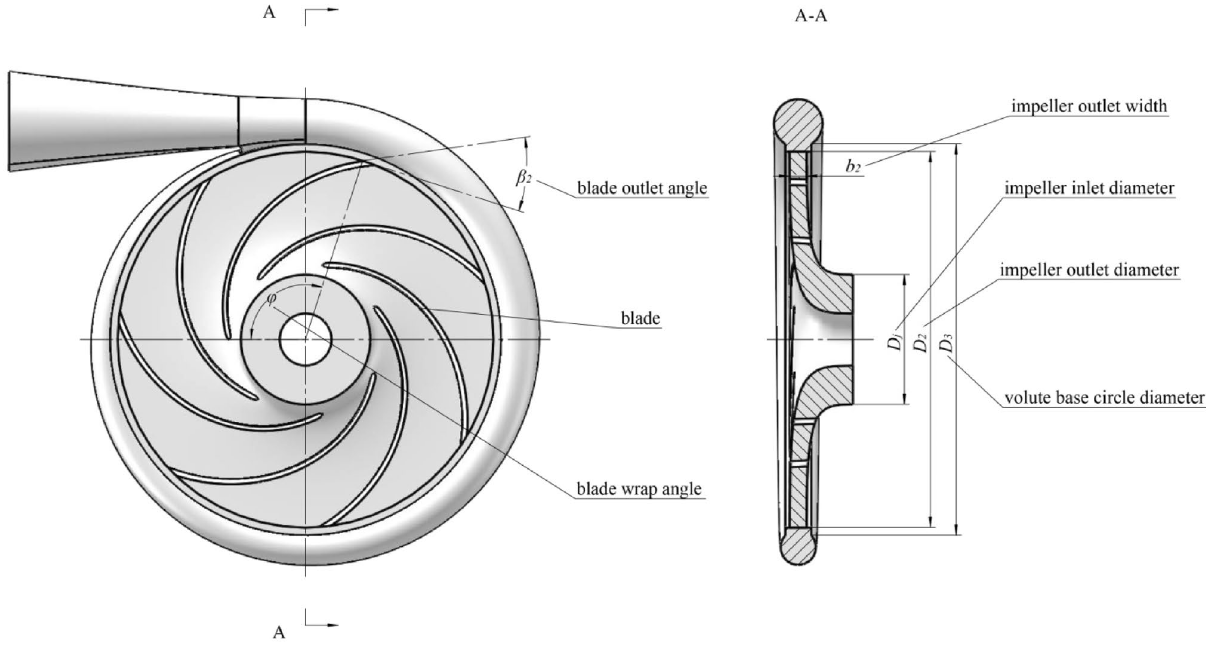
Figure 1. Calculation